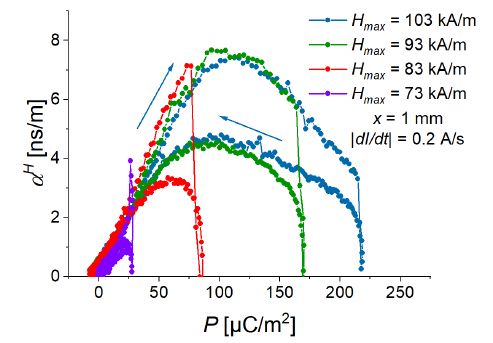
Figure 11. Dependence of the ME coupling coefficient on the electric polarization for four peak values of magnetic field ( H max = 73, 83, 93, and 103 kA/m) and a sample with an MAE layer thickness of 1 mm at the magnetic slew rate of 12.2